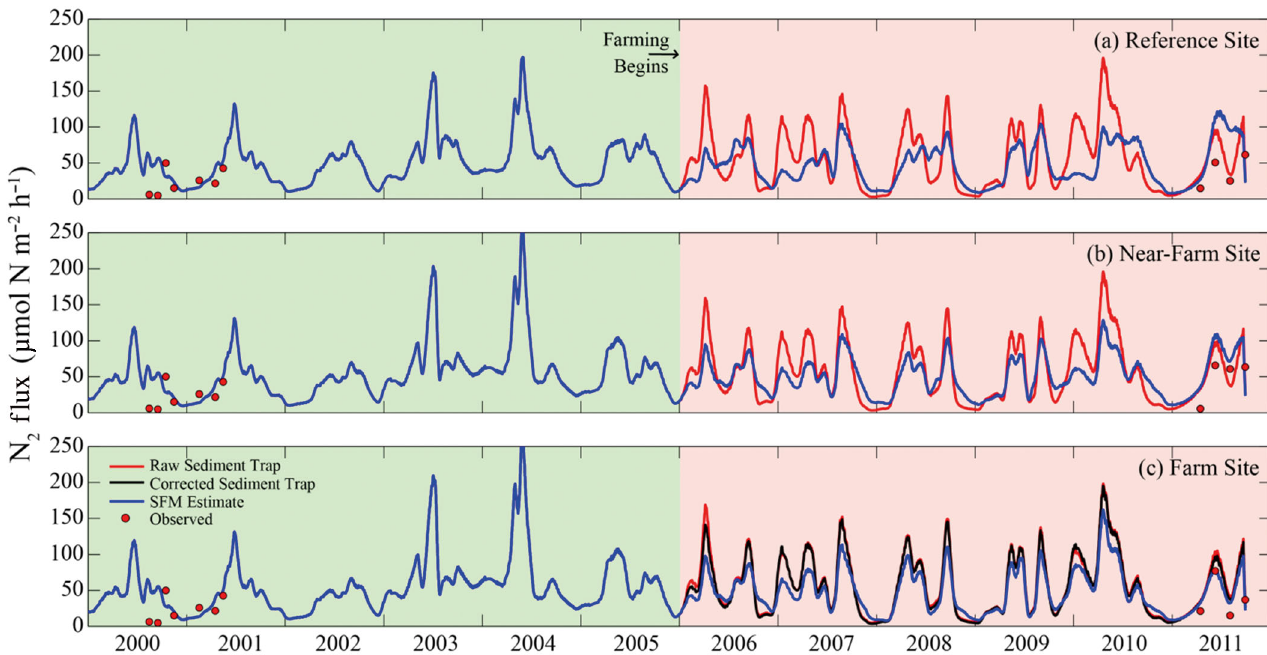
Fig. 7. Time-series (2000−2011) of modeled (lines) and observed (red circles) N 2 fluxes at (a) reference, (b) near-farm, and (c) farm sites. Green and red shading indicates pre- and post-oyster farming periods, respectively. Red line: uncorrected raw sediment trap estimates, black line: farm site sediment trap estimates corrected for resuspension, blue line: deposition esti- mated by sediment flux model (SFM) by fitting deposition to the observed sediment–water NH 4+